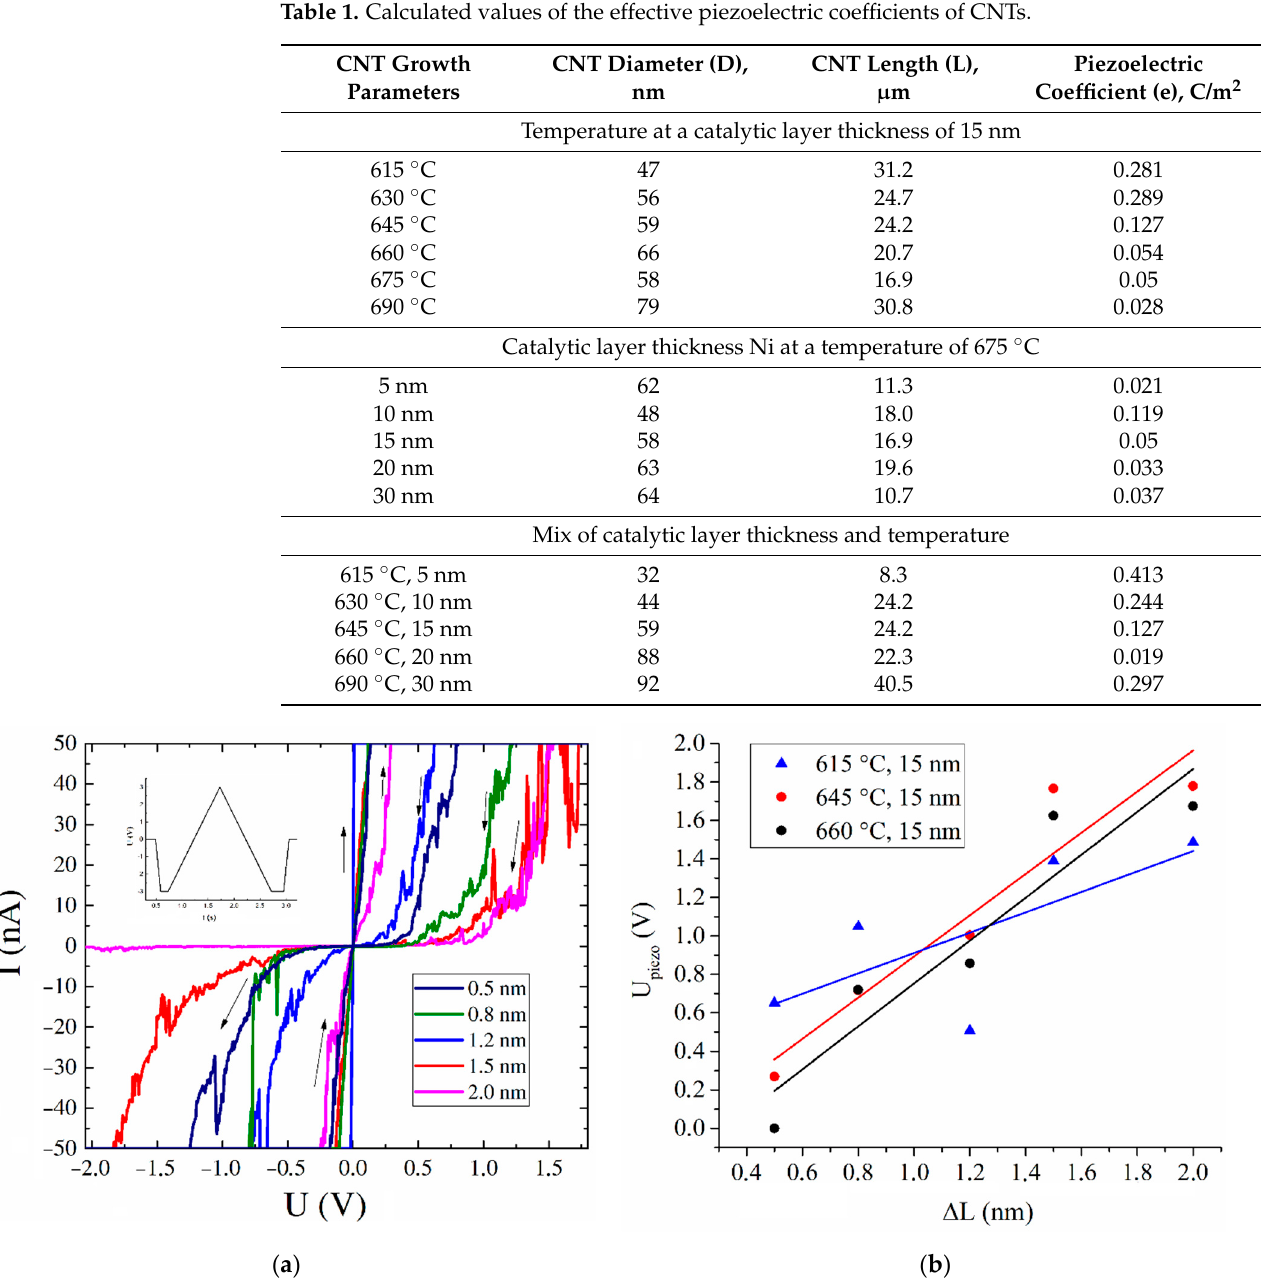
Figure 4. Current–voltage characteristic of CNTs grown at T = 615 °C and t = 15 nm at different tensile strain values Δ L ( a ). The CVCs were obtained by applying a sawtooth voltage pulse with an amplitude of 3 V and a duration of 1 s. Dependence of the potential difference between the top and bottom of the CNT (U piezo ) on the value of the relative deformation of CNTs grown at different temperatures ( b ).